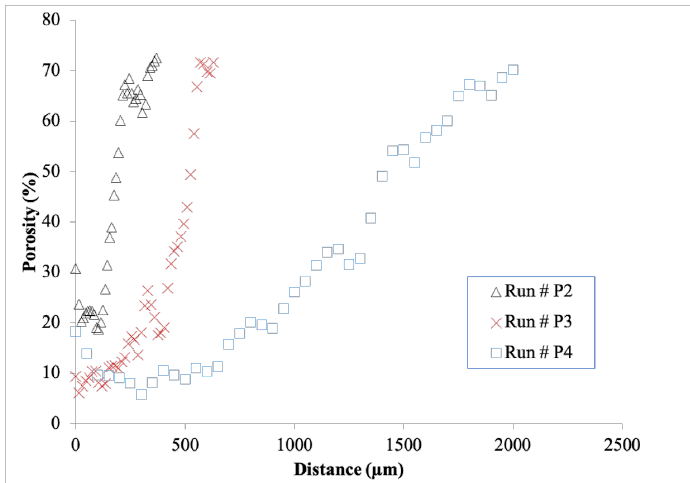
Figure 8. Micrographs of the cross-section for 3 successive infiltrations #P2, P3, and P4, from left to right.